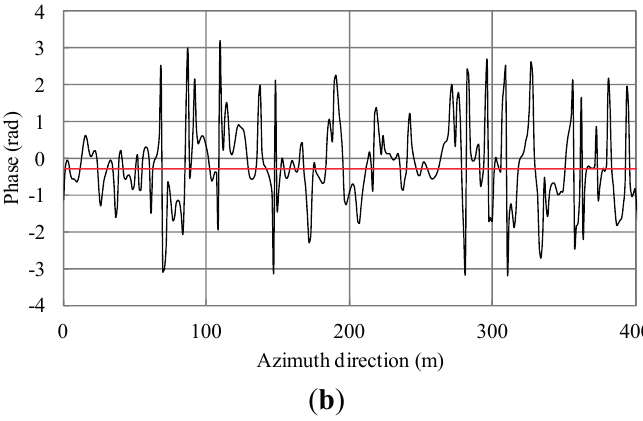
Figure 8. Simulation results of additional current and irregular waves for wind speed 5 m/s. ( a ) Phase of simulated SAR signals of master and slave antennas in the azimuth direction. ( b ) Phase differences of (a). The black line shows the phase differences. The red line shows the average.